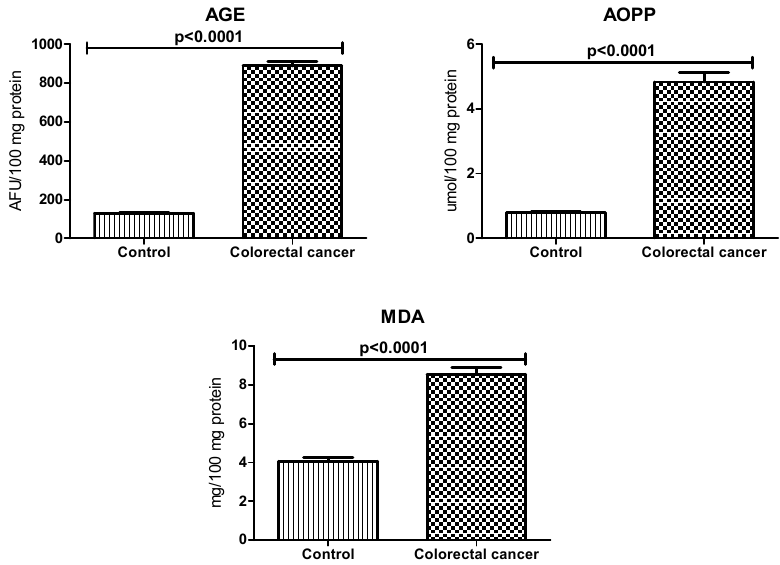
Figure 4. Oxidative damage to proteins and lipids in patients with colorectal cancer and the control group. Abbreviations: AGE, advanced glycation end products; AOPP, advanced oxidation protein products; MDA, malondialdehyde.